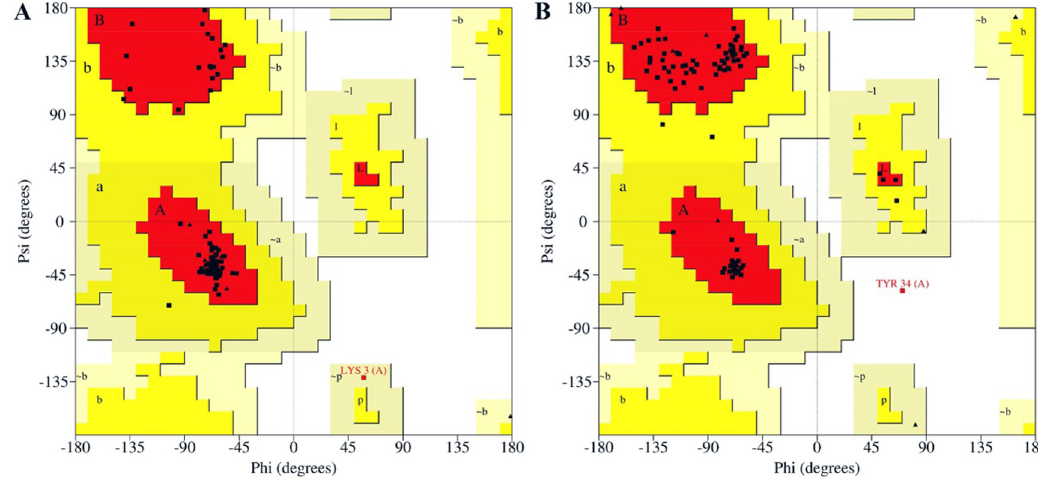
Fig 3. Ramachandran plot of A) ht-MAP2191 and B) ht-FAP-P.